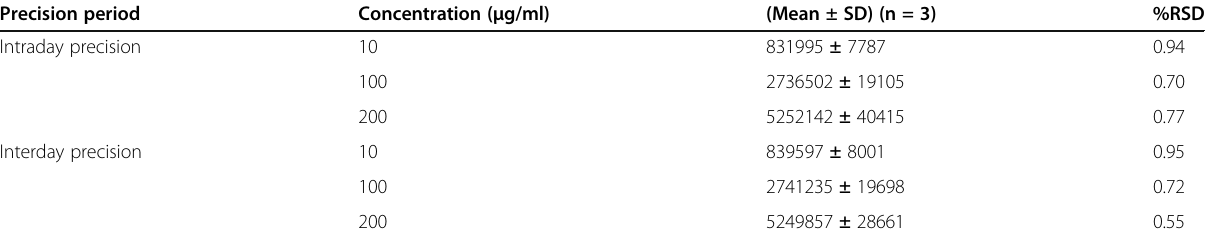
Table 5 Data for intraday and interday of ceftriaxone sodium Precision period